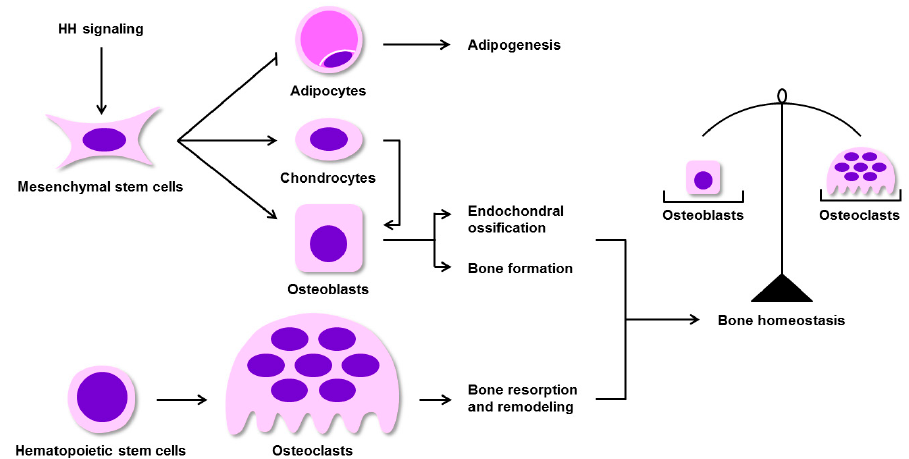
Figure 2. HH signaling is an essential for maintaining bone homeostasis. HH signaling promotes BM-MSC differentiation into chondrocytes and osteoblasts (two cell types involved in endochondral ossification), and inhibits BM-MSC differentiation into adipocytes (associated with adipogenesis). Osteoblasts mediate bone formation, whereas the hematopoietic system-derived osteoclasts drive bone resorption and remodeling. The balance of osteoblast and osteoclast activities is essential for the maintenance of bone homeostasis. BM-MSCs, bone marrow mesenchymal stem